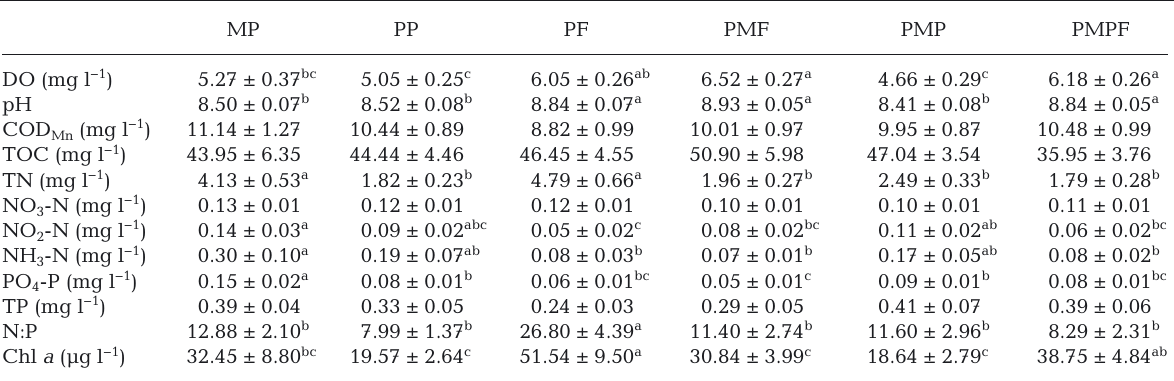
Table 2. Mean ± SE water quality parameters over the entire duration of the culture. Different superscript letters within rows indicate significant (p < 0.05) differences between groups. Treatment groups are defined in Table 1. DO: dissolved oxygen; COD: chemical oxygen demand; TOC: total organic carbon; TN: total nitrogen; TP: total